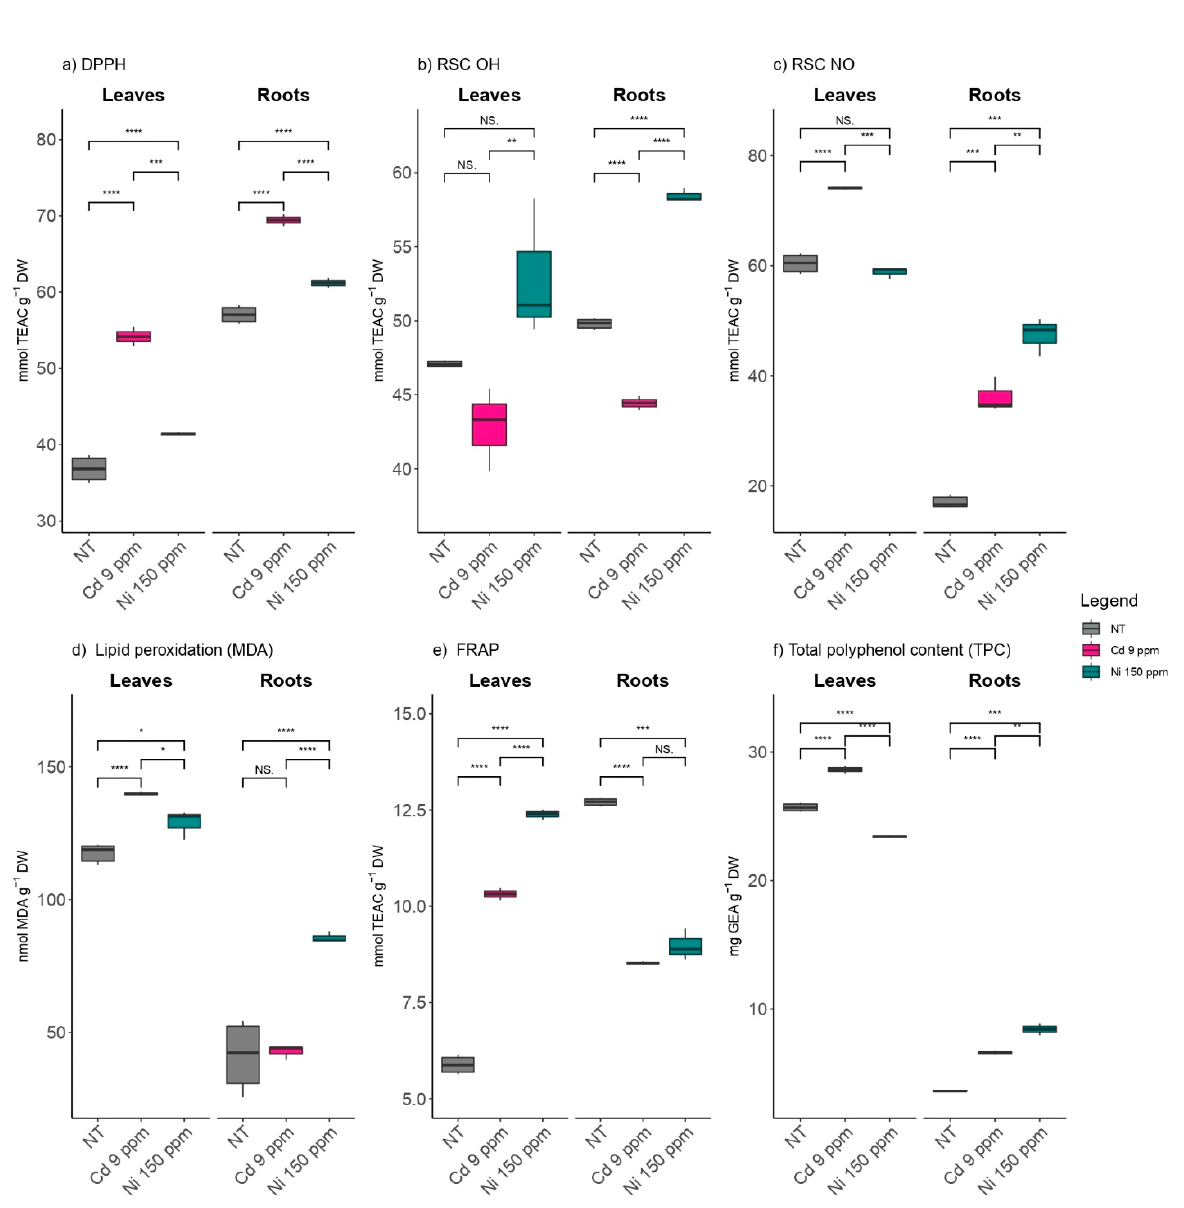
Figure 2. The effects of elevated Cd and Ni soil contents on radical scavenger activities against ( a ) DPPH, ( b ) OH, and ( c ) NO radicals, as well as ( d ) lipid peroxidation, ( e ) ferric reducing antioxidant power (FRAP), and ( f ) total polyphenol content (TPC) at root and leaf levels using NT-non treated soil. Cd 9 ppm-soil was supplemented to 9 mg Cd kg − 1 of soil DW and Ni 150 ppm-soil was supplemented to 150 mg Ni kg − 1 of soil dry weight. Significance levels: (NS) non-significant versus significant (*) <0.05; (**) <0.01; (***) < 0.001; and (****) <0.0001.